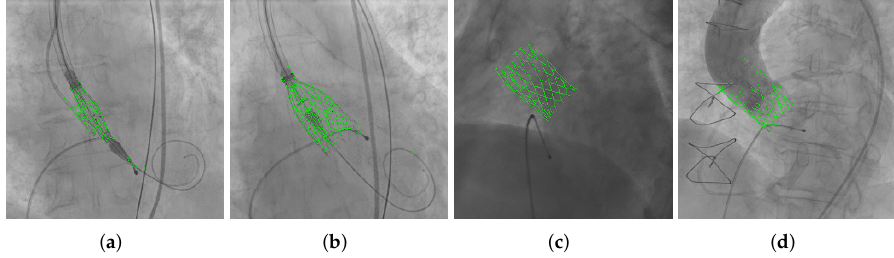
Figure 4. Different types of frames with their segmentation results (overlaid in green) obtained using Otsu’s method. ( a ) THV loaded in the deliverery catheter, previous to the deployment. ( b ) THV deployment. ( c ) THV totally deployed and expanded. ( d ) THV with contrast agent